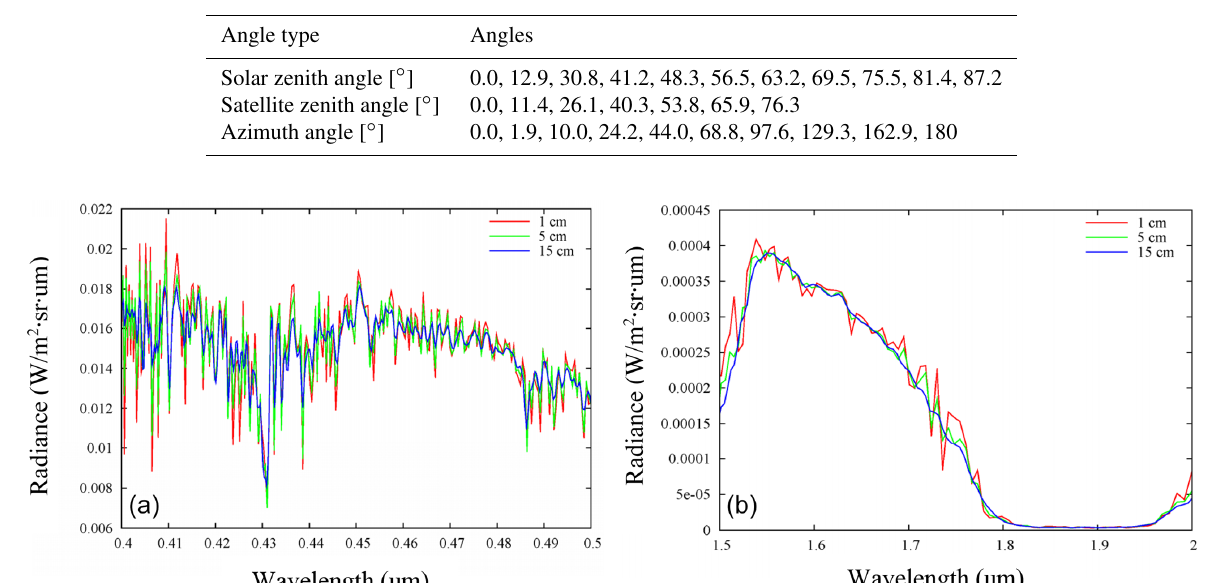
Table 4. Angles used in simulations. To be consistent with what is presented in the ABI Shortwave Radiation Budget (SRB) Algorithm Theoretical Basis Documents (ATBD) (Laszlo et al., 2018) the additional angles used in the simulations are not given in this table.